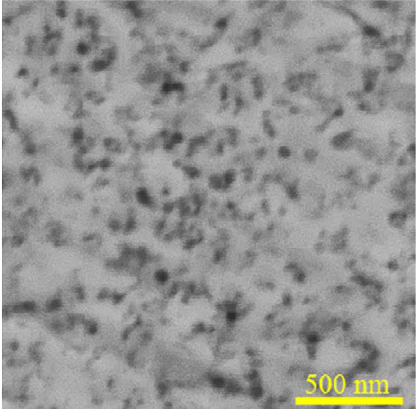
Fig. 1. Backscattered SEM micrograph from cross-section of Co-Cr/5.8vol.%TiO 2 coating.